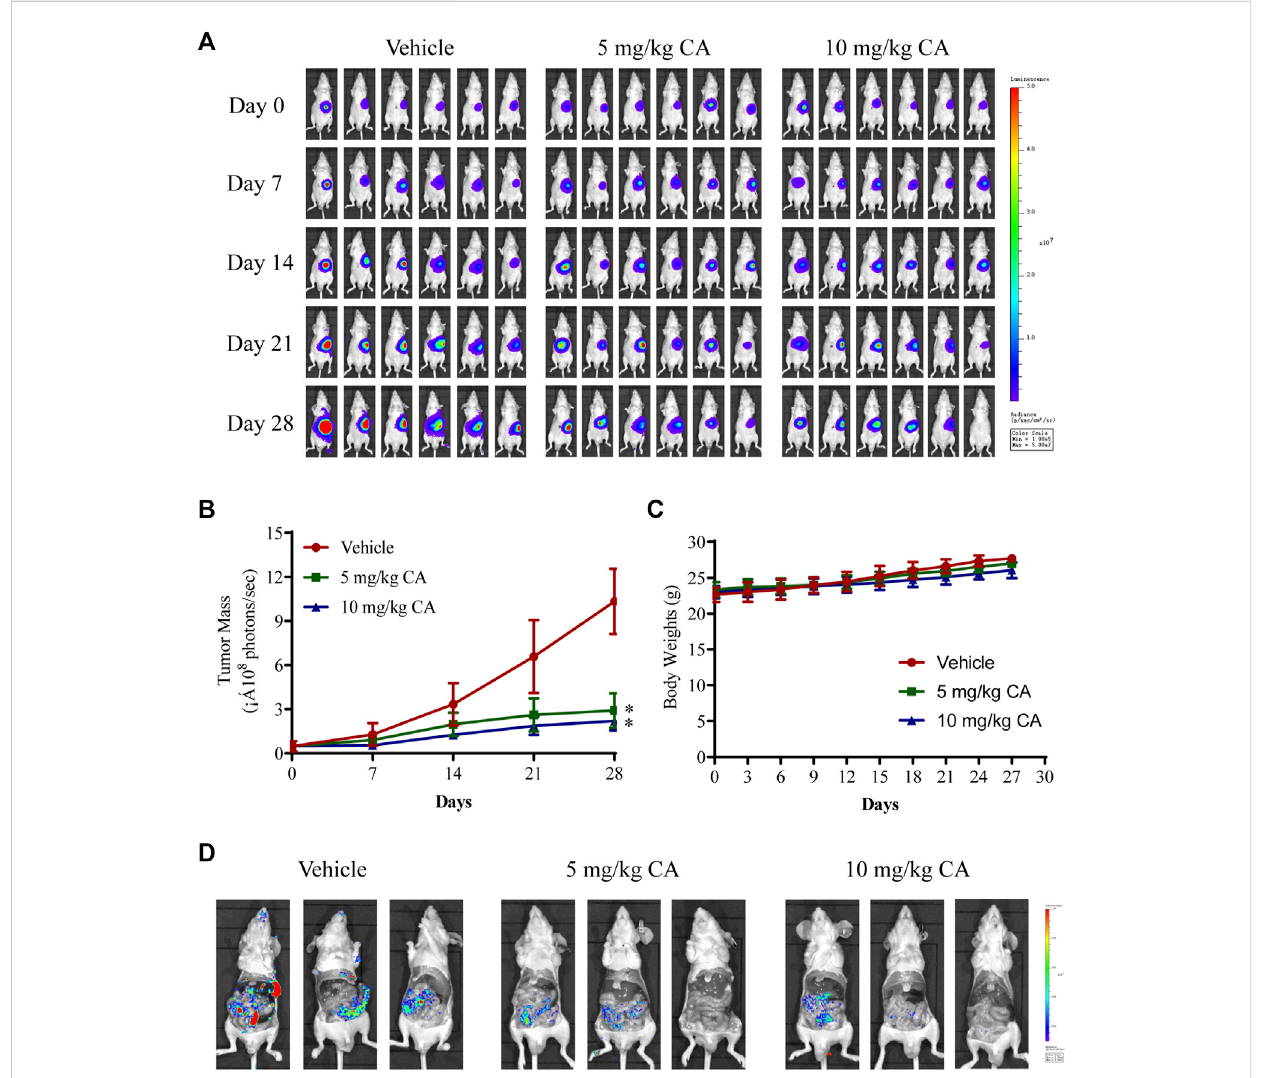
FIGURE 5 Inhibition effect of CA on tumor growth and metastasis of GC in MKN1 orthotopic mice models. (A) Fluorescence images of the tumor were detected every 7 days for 4 weeks. (B) The tumor mass curves of mice during 4 weeks. (C) Average body weight of mice during 4 weeks. (D) Representative fl uorescenceimagesofperitonealmetastasisoftumor.* p < 0.05comparedtothevehiclegroup(n=6).One-wayANOVAtest.Alldataare shown as the means ±